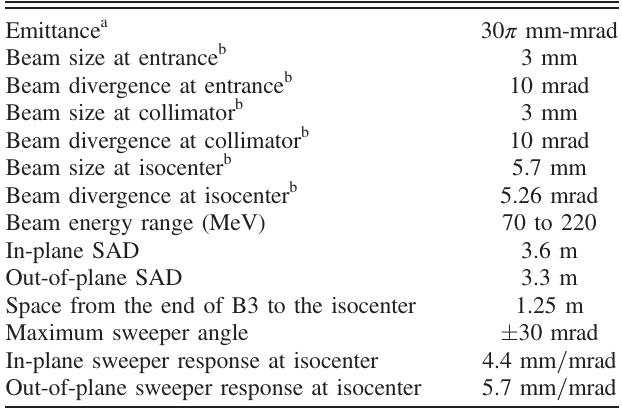
TABLE IV. Beam and linear gantry properties calculated from SCOFF